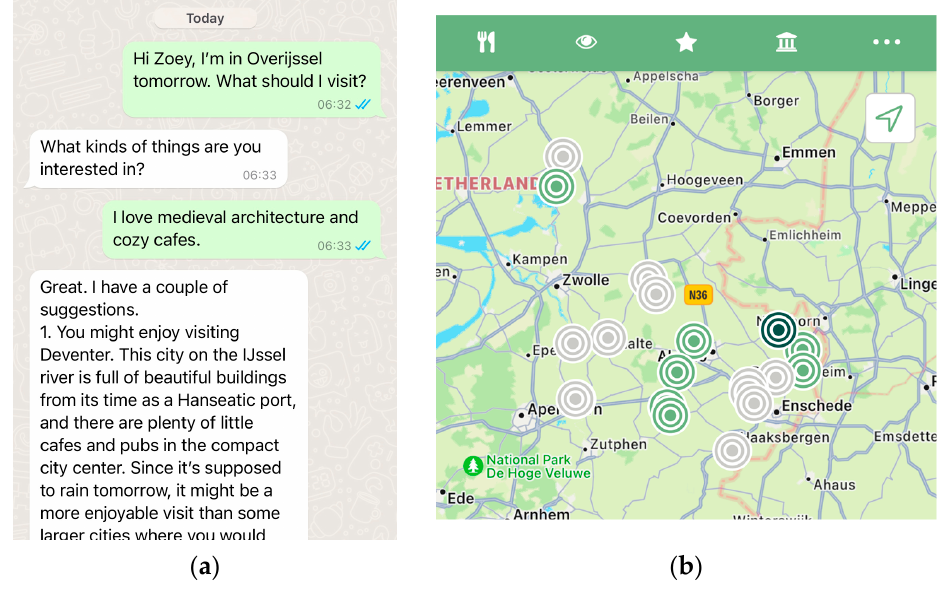
Figure 1. Screenshots of conversational ( a ) and passive ( b ) recommender destination information. As a region benefiting from tourism, but also facing intense tourist flows in a handful of heavily visited areas, Overijssel is an ideal context for the present study. This province of 1.16 million inhabitants is located in the northeast of The Netherlands, and borders Germany to the east and other Dutch provinces to the north, south, and west. The province covers a total of 342,273 hectares, of which 6773 (1.98%) are covered by recreational areas and 34,474 (10.07%) by forest. While existing discourse about overtourism largely concerns cities, especially large, internationally famous historic city centers such as Venice or Amsterdam, the situation is somewhat inverse in Overijssel. While there are several Hanseatic historic city centers which attract tourists, such as Zwolle (2021 population 129,840) and Deventer (2021 population 101,236), these cities are considered relatively less-visited areas by Marketing Oost for the purpose of the present study. In contrast, the town of Ootmarsum (2021 population 4460), the village of Giethoorn (2021 population 2805), and several natural and agricultural landscapes such as the Vecht valley and the Sallandse Heuvelrug National Park comprise the heavily visited areas of Overijssel. Thus, the policy to spread tourists away from heavily visited areas in Overijssel corresponds with the goal to increase visits to urban areas. In contrast, a region such as Amsterdam might indicate fewer tourists in urban areas as a policy goal to reduce crowding. The experiment featured a during- and post-intervention measurement design. Participants were asked to fill in an intake questionnaire, including demographics and informed consent, approximately one month before their vacation. Location and emotions were measured daily during the vacation. Finally, on the last day of their vacation, participants were asked to evaluate the information source to which they were assigned (passive app or conversational recommender) and their vacation as a whole. 3.2. Sample We used an availability sampling approach during two waves of data collection in May 2021 and late July/early August 2021. For field research in tourism contexts, availability samples being used as probability samples is practically impossible due to the lack of a sampling frame. Even if a sampling frame such as all visitors entering a region were practically possible, not only do tourist behaviors and experiences differ season to season, but also year to year. That makes a true probability sample of tourist experiences not only practically, but also conceptually unattainable. Participants were approached based on the criterion of booking a vacation at one of 10 (May) or 8 (August) vacation parks that chose to cooperate with the project. These parks